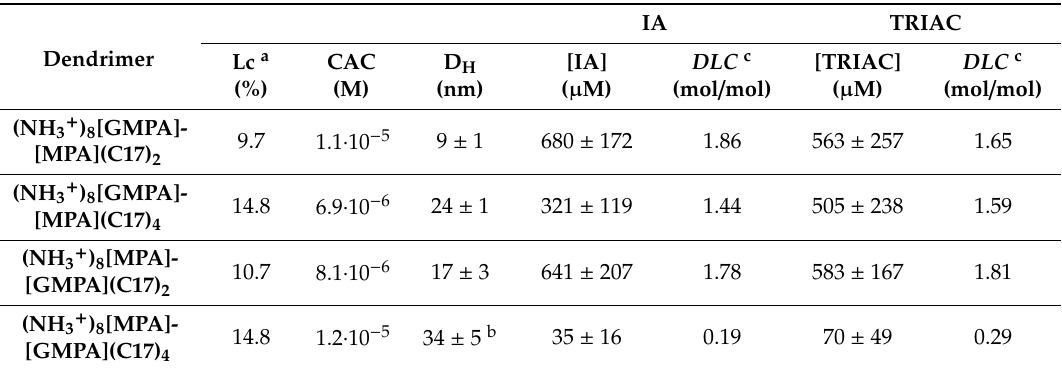
Table 1. Lc and critical aggregation concentration (CAC) values for the amphiphilic Janus dendrimers, number average hydrodynamic diameters, D H , of the dendritic aggregates measured by DLS and amount of IA and TRIAC loaded within the Janus